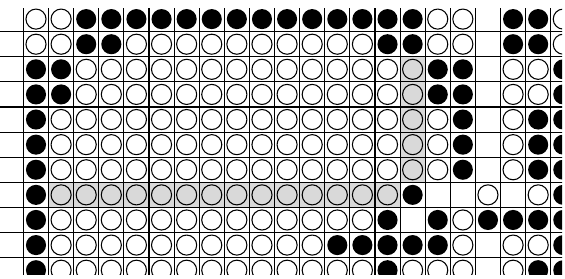
Figure 67. BLACK intrudes.